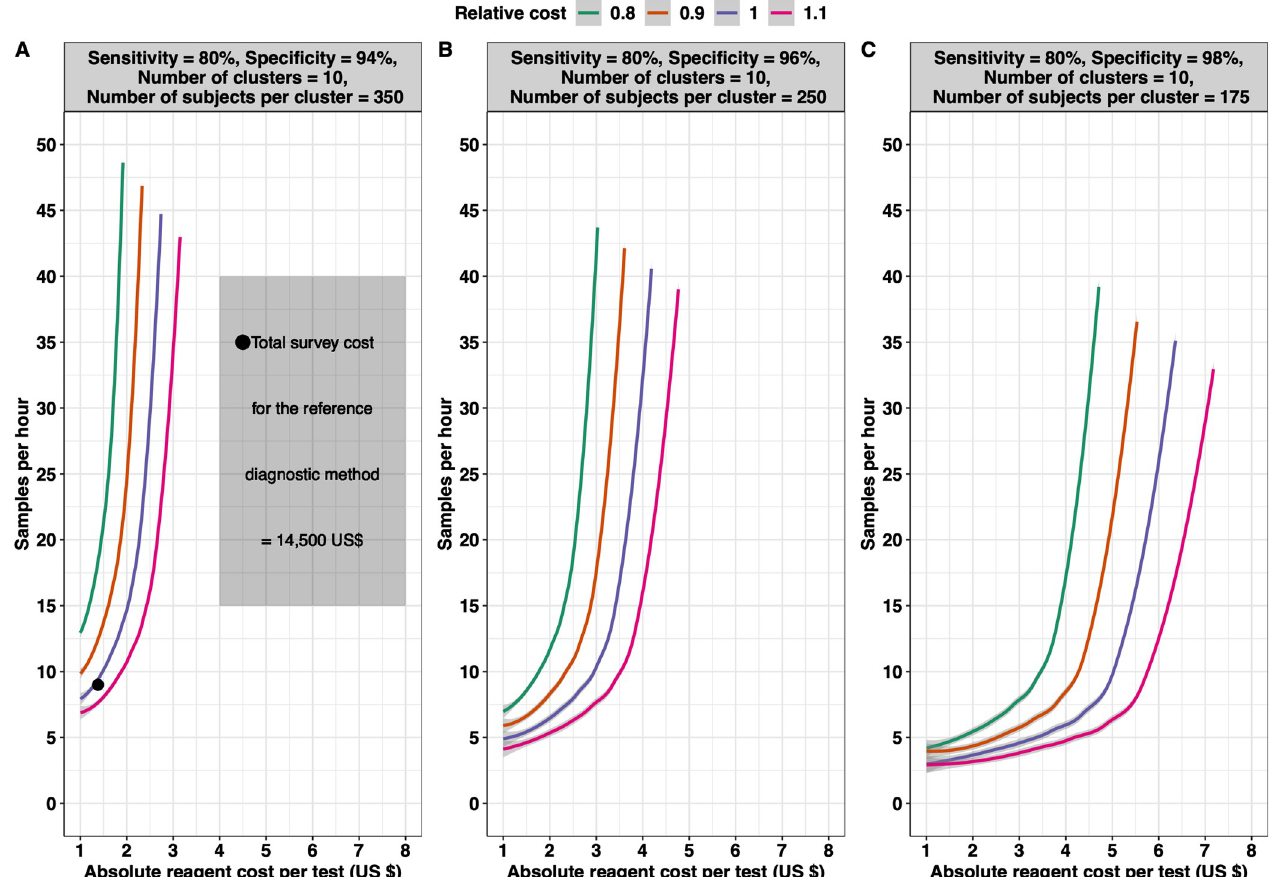
Fig 8. The relative total survey cost of imperfect diagnostic tests with varying sample throughput and reagent costs. The contour lines illustrate the total survey cost when applying imperfect diagnostic tests with varying sample throughput and reagent cost to test one sample relative to the total cost of a survey based on the hypothetical reference diagnostic test with the sample throughput (9 samples per hour per person) and cost characteristics (1.38 US$ reagent test cost) of single Kato-Katz thick smear. We considered three hypothetical diagnostic tests D t 3 (reference diagnostic test; Panel A ), D t 2 ( Panel B ), and D t 3 ( Panel ¼ 80 % ; sp ¼ 98 %; D : se ¼ 80 % ; sp ¼ 96 %; D : se ¼ 80 % ; sp ¼ 94 % ). The C ), each with a different diagnostic performance ( D se t 1 : dt 1 t 2 dt 2 t 3 dt 3 dt 1 dt 2 dt 3 intra-cluster correlation ρ was set at 0.02 and the number of clusters at 10. The number of subjects per cluster and the total survey cost was defined as the i minimum required number of subjects per cluster and minimal cost required for adequate decision-making ( E overtreat = 25 % and E undertreat = 5 %) around a program prevalence threshold of 2%, with the grey zone defined as T ± 50 % ( LL = 1 % and UL = 3 %). All three panels were based on 10,000 Monte Carlo simulations.